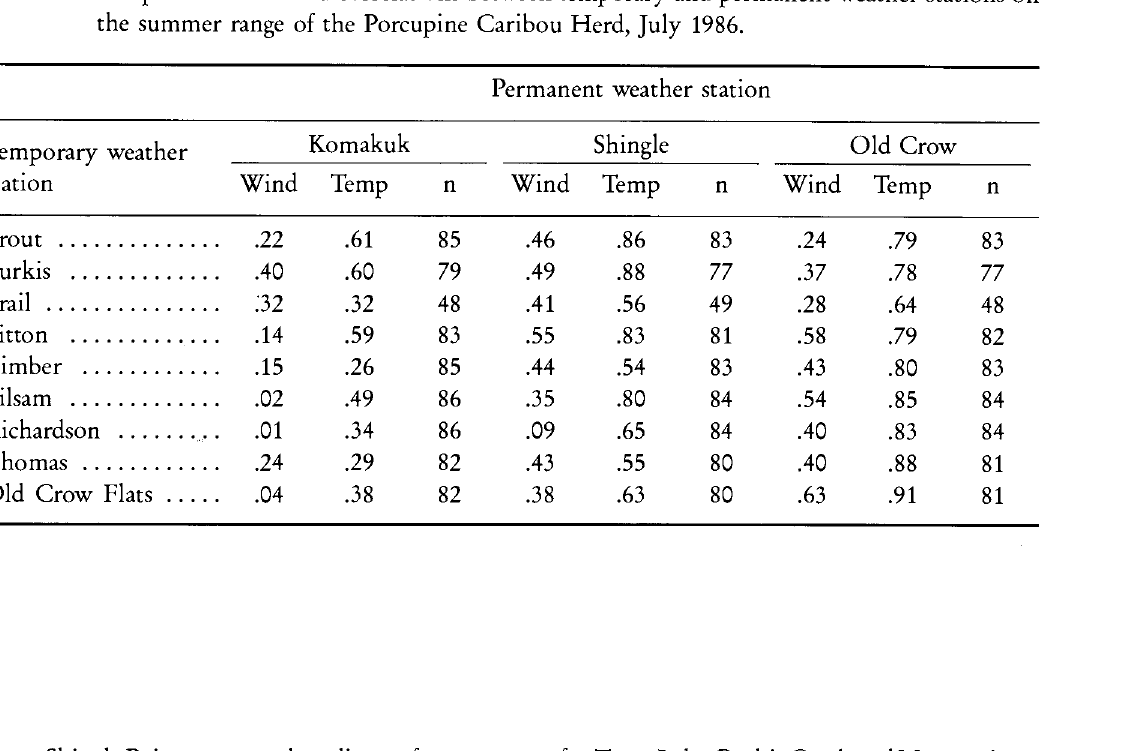
Table 4.2. Temperature and wind correlations between temporary and permanent weather stations on the summer range of the Porcupine Caribou Herd, July